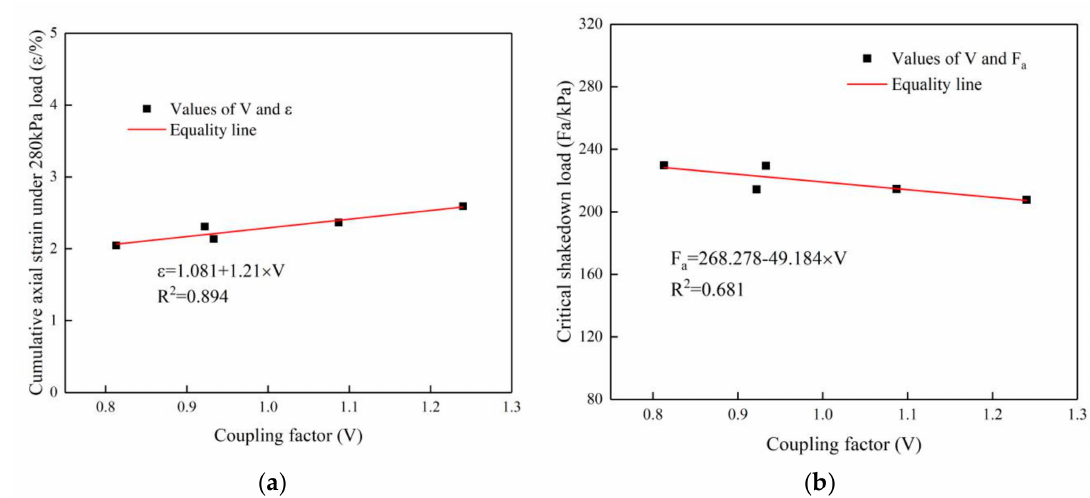
Figure 16. ( a ) Regression analysis between coupling factor and cumulative axial strain under a cyclic rotating axial compression of 280 kPa; ( b ) regression analysis between coupling factor and critical shakedown load.